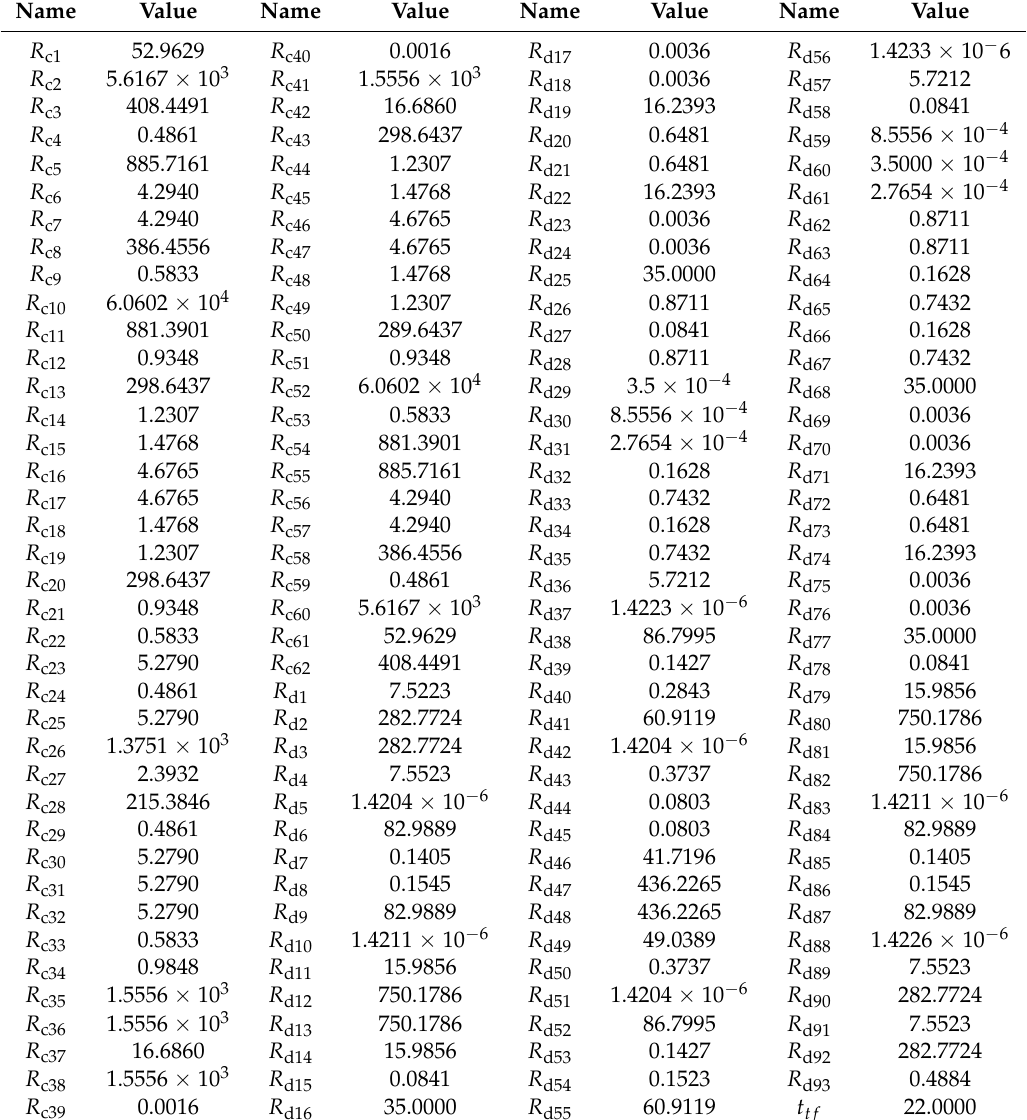
Table A1. Parameter Values in the Thermal